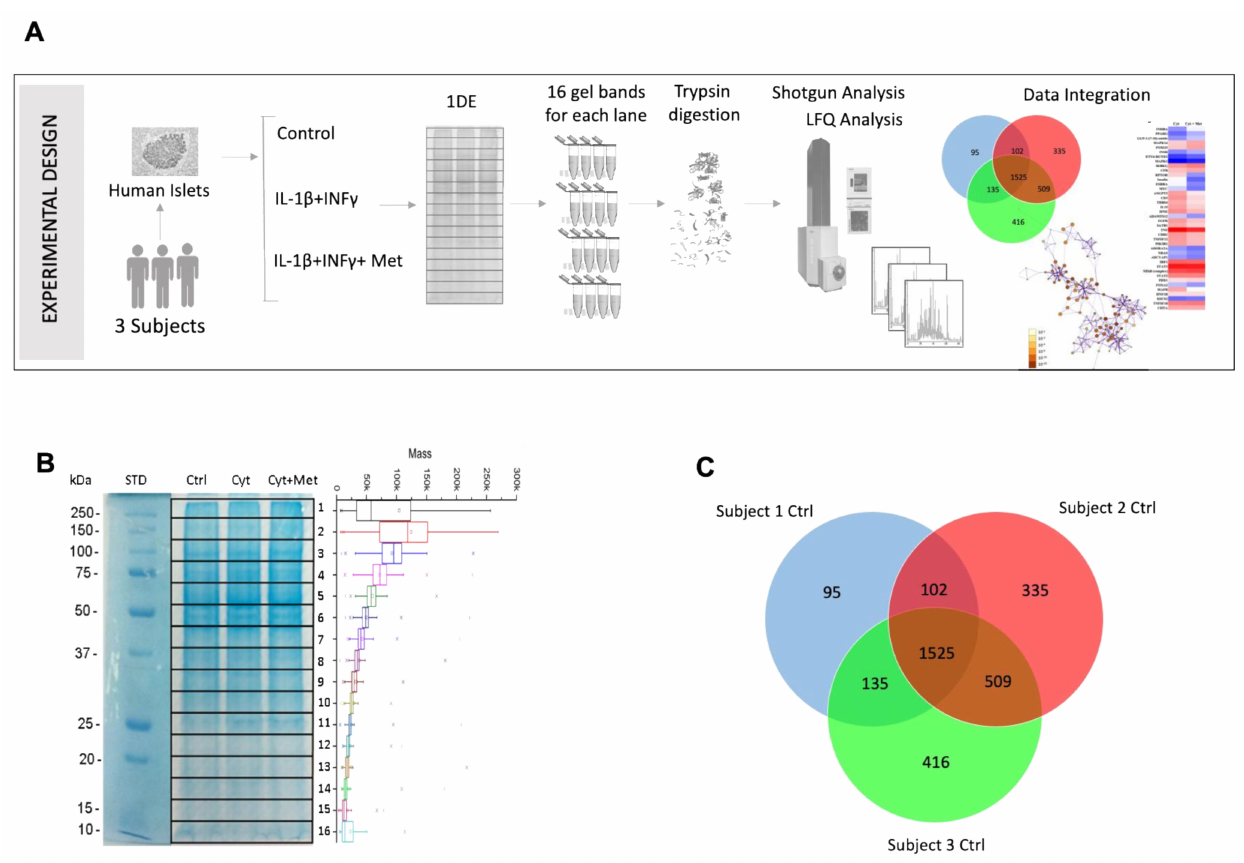
Figure 2. Global view of the proteomics analysis of human pancreatic islets treated with cytokines in the absence and in the presence of metformin using shotgun proteomics. ( A ) Experimental design of the proteomics analysis of pancreatic islets. ( B ) A representative 1DE gel in which the 16 extracted bands are highlighted and paired to the corresponding average mass of the proteins identified in each band. ( C ) Venn diagram showing the number of proteins found in the control